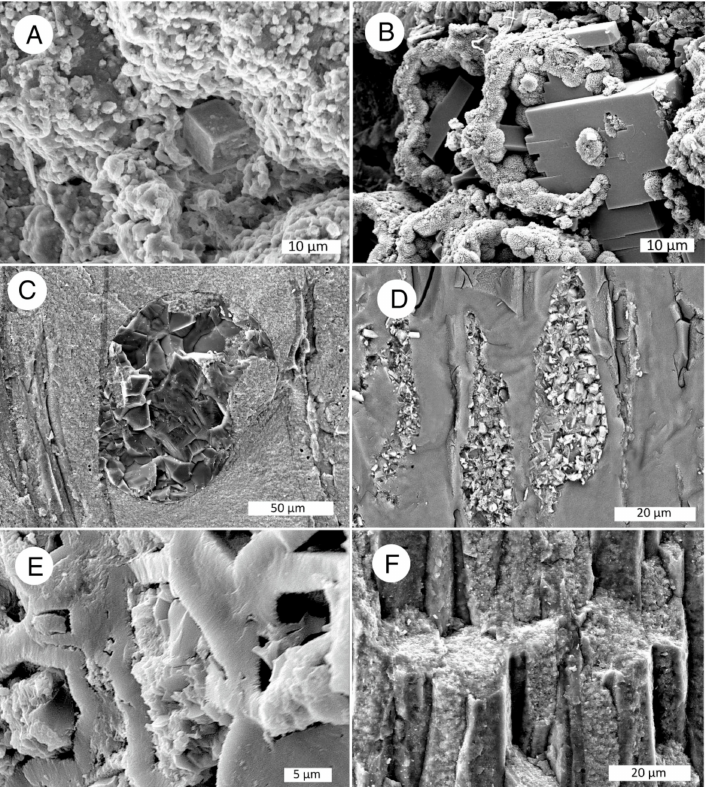
Figure 39. SEM images of accessory minerals. ( A ) Cubic pyrite crystal in Cretaceous wood from Texas, USA appears to have been formed contemporaneously with silicification of the adjacent cells. ( B ) Transverse view of Miocene wood from Royal Peacock Mine, Virgin Valley, Nevada, USA shows cell walls mineralized with opal-CT that is intergrown with zeolite crystals, which formed from elements released by dissolution of the tephra-rich matrix. Zeolite only occurs near the specimen end grain surface, indicating shallow penetration of the zeolite parent elements. ( C ) A vessel in silicified Paleocene wood from Cherokee Ranch, Colorado, USA contains calcite crystals formed during late-stage mineralization. ( D ) Cell lumen in Miocene wood from northwest Iran are filled with apatite microcrystals. ( E ) Cell lumen in another specimen from the same Iran locality are filled with gypsum. ( F ) Oblique radial view of Paleocene wood from Cherokee Ranch, Colorado, USA showing cells filled with iron